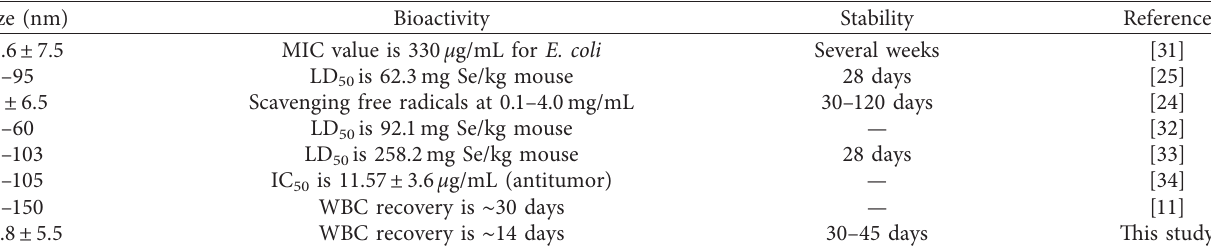
Figure 8: Total WBC counts in irradiated mice, which were orally supplemented with OCS, SeNPs/OCS, and PBS buffer (control group) for 40 days, as well as after stopping oral supplementation for 30 days. ∗ p < 0.05, significant difference to the control group; ∗∗ p < 0.05, significant difference of SeNPs/OCS to the OCS-supplemented group. Table 1: Characterisation of some synthesised